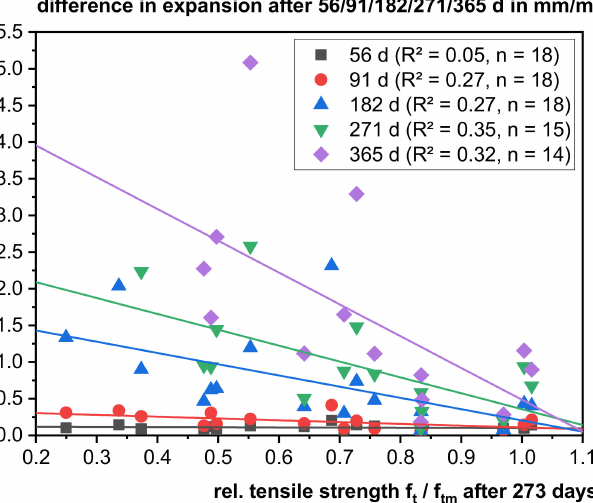
Figure 4. Correlation of the difference in expansion (SVA method, 3000 mg SO 42 − /L, 5 ◦ C) over the course of time and the relative tensile strength f t /f tm after 273 days.